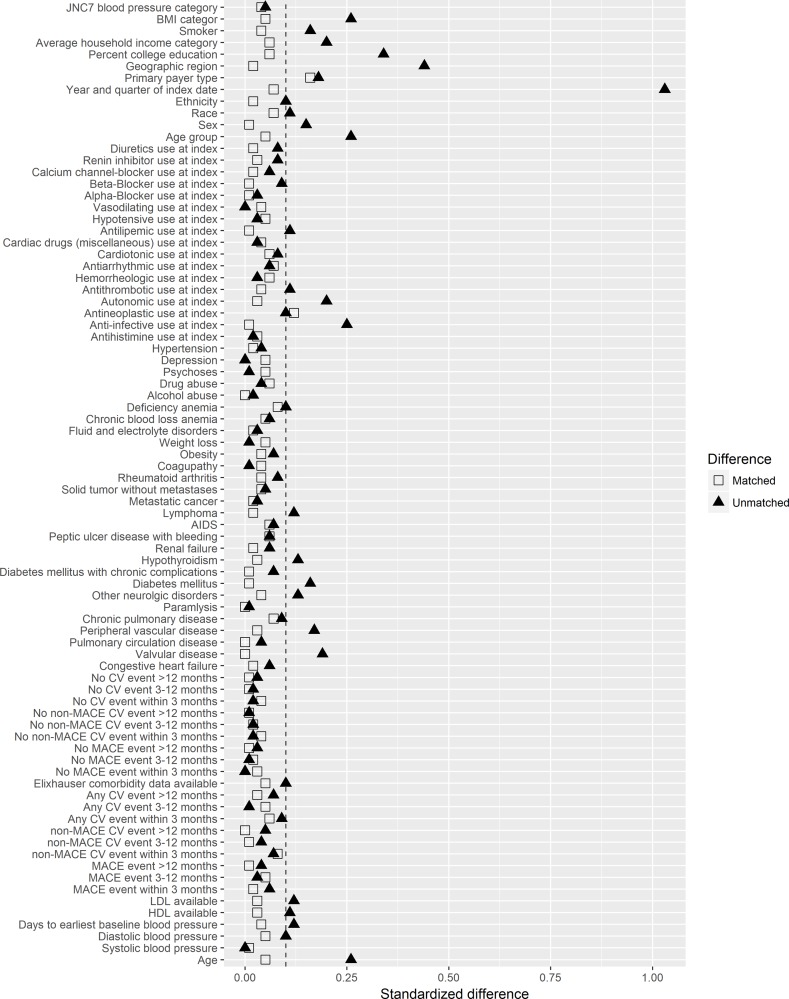
Standardized differences before and after propensity score matching.